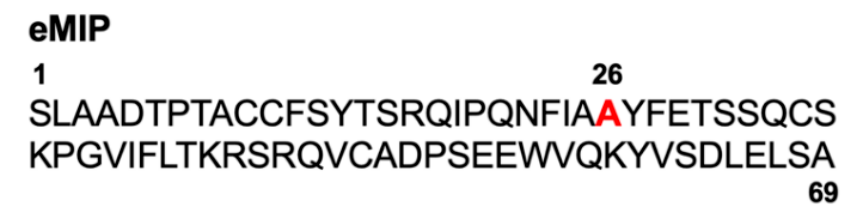
Figure 4. Amino acid sequence of eMIP .